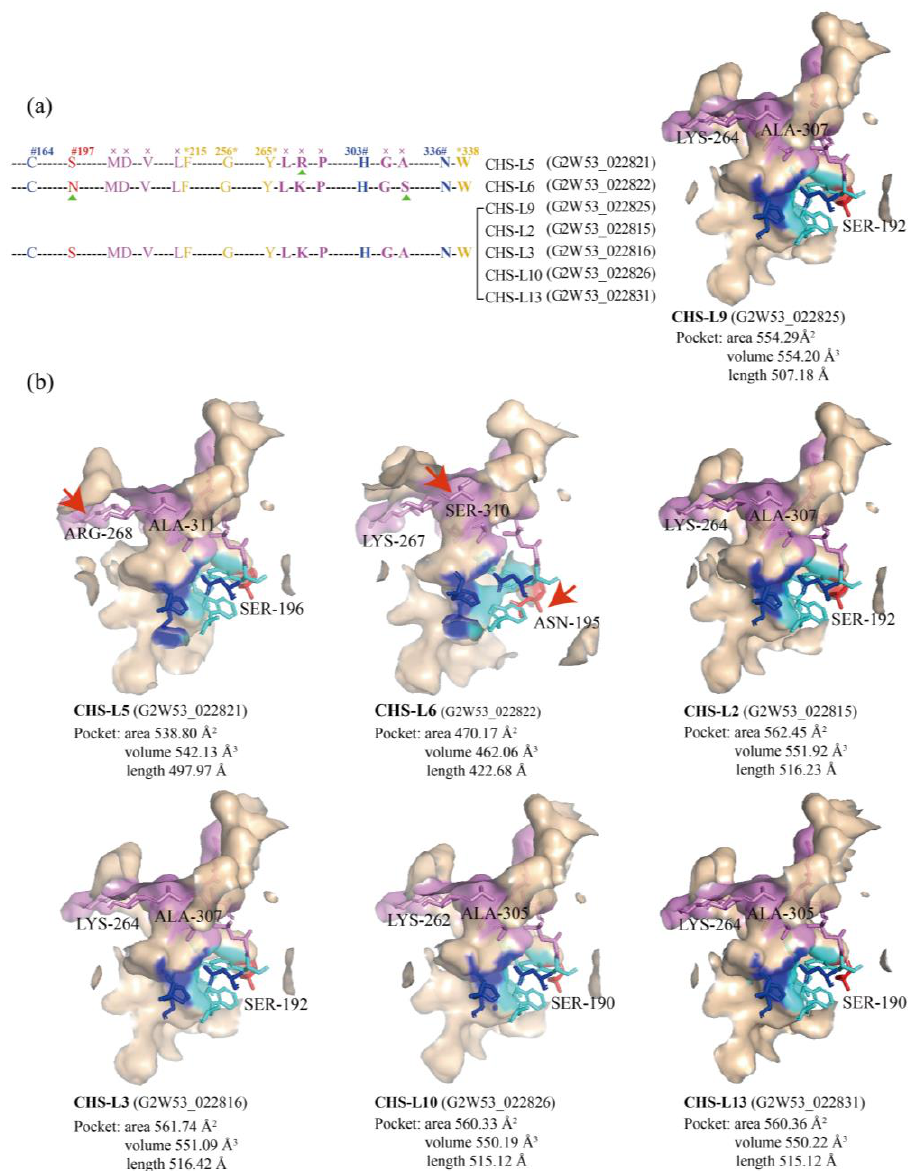
Figure 7. The analysis of the active-site residues and model structures of seven CHS-L proteins in Senna tora . ( a ) The catalytic active-site residues and CoA binding residues of six CHS-L proteins. The catalytic triad (Cys164, His303 and Asn336) (in blue) and the critical active-site residue 197 (in red) are marked with #; the residues lining the active site (Phe215, Gly256, F265, and Ser338) (in yellow) are marked with * (numbering in M. sativa CHS), and the residues for the CoA binding (in purple) are marked with × . ( b ) Comparison of the 3D predicted protein structures of the seven CHS-L proteins. The active-site residues differing from other members are marked with red arrows.